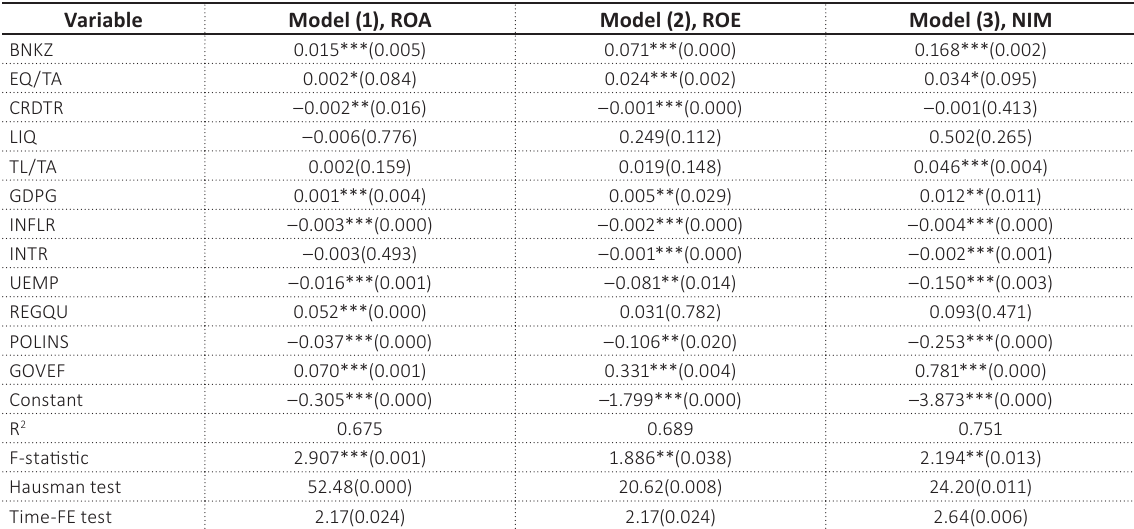
Table 4. Estimation